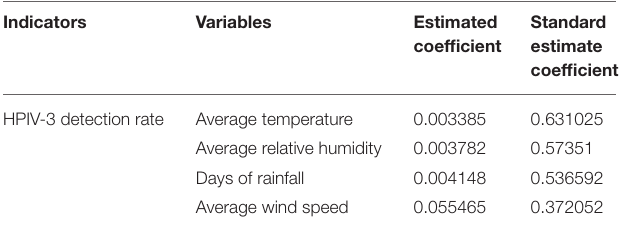
TABLE 2 | Correlation between HPIV-3 detection rate and meteorological factors according to least absolute shrinkage and selection operator (LASSO)-based